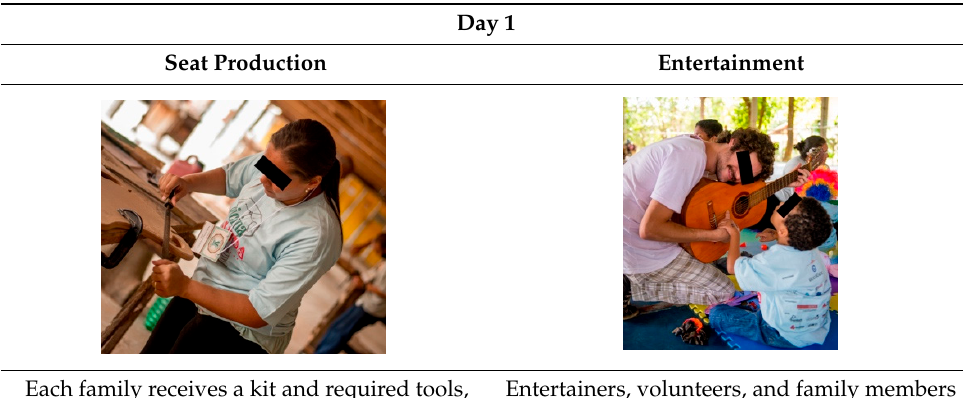
Table 1. The first day of the Ciranda Workshop event.